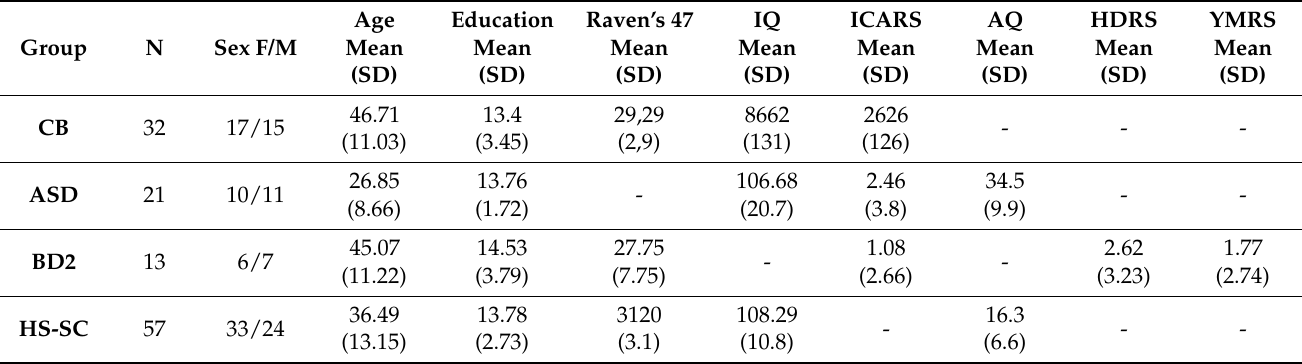
Table 1. Demographic characteristics and clinical scores of the studied